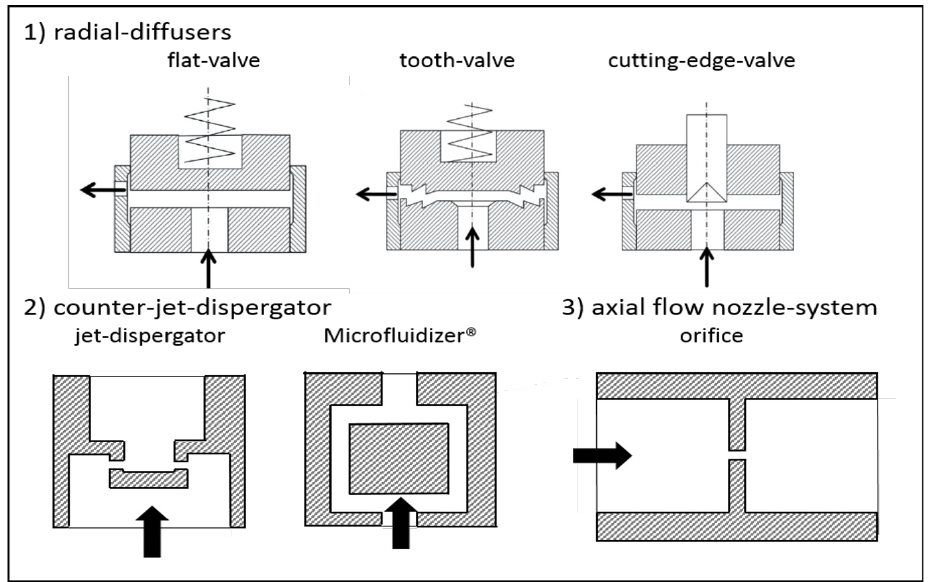
Figure 1. Disruption units in high-pressure homogenization. ( 1 ) radial-diffusers (reproduced with the permission from [3]; Behrs Verlag, 2012); ( 2 ) examples for counter-jet-dispergator: jet-dispergator adapted from [24], Microfluidizer ® adapted from [25]; ( 3 ) axial flow nozzle-system.